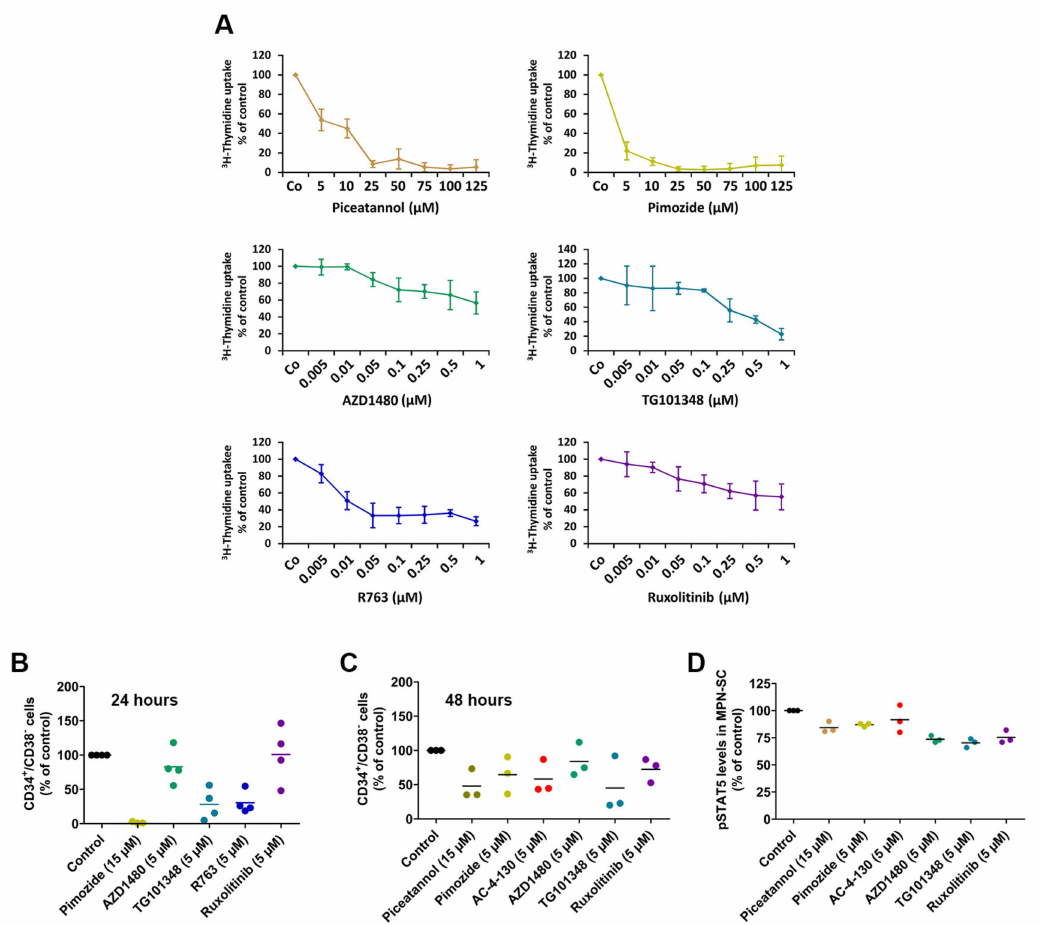
Figure 6. ( A ) Mononuclear cells isolated from the bone marrow of MPN patients were incubated with di ff erent concentrations of JAK2 or STAT5 targeting drugs for 48 h. Thereafter, 3 [H]-thymidine was added for 16 h and its incorporation was analyzed using a beta counter. The diagrams show the mean ± SD of three independent experiments for JAK2-targeting drugs (patients #07, #20 and #23) or five independent experiments for STAT5-targeting drugs (patients #20, #23, #37, #35 and #39). ( B , C ) Mononuclear cells isolated from the bone marrow of MPN patients were incubated with di ff erent concentrations of JAK2 or STAT5 targeting drugs for 24 h ( B ) or 48 h ( C ). Then, the numbers of putative MPN stem cells (MPN-SC), defined as CD34 + / CD38 − / CD45 dim , were assessed using counting beads. The graphs show MPN-SC as percent of control in four patients (#14, #29, #30 and #31) in ( B ) and in three patients (#31, #42 and #43) in ( C ). Horizontal lines indicate mean values. ( D ) pSTAT5 levels in CD34 + / CD38 − MPN-SC determined by flow cytometry (same patients as in ( C )) after an incubation with targeted drugs (as indicated) for 4 h. Values represent pSTAT5 levels relative to the control. The mean staining index is also shown (horizontal bars). Patient characteristics are shown in Table